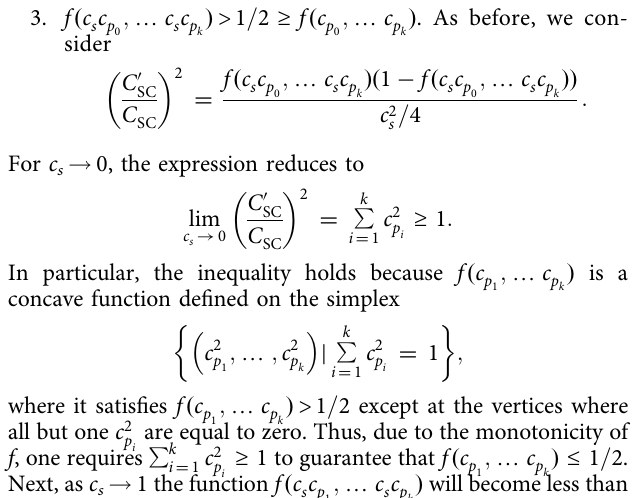
q ffiffiffiffiffiffiffiffiffiffiffiffiffiffiffiffiffi ffiffiffiffiffiffiffiffiffiffiffiffiffiffiffiffiffi þ 1 (cid:2) c 2 s c 2 p 1 (cid:2) c 2 s c 2 p j i j (cid:6) ffiffiffiffiffiffiffiffiffiffiffiffiffiffiffiffiffi q ffiffiffiffiffiffiffiffiffiffiffiffiffiffiffiffiffi q ; 1 (cid:2) c 2 s c 2 p 1 (cid:2) c 2 s c 2 p i j